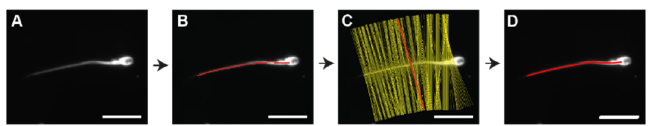
Figure 2. Reconstruction of the flagellum. ( A ) Each frame image is segmented and skeletonized to obtain ( B ) a rough track (red) of the flagellum; ( C ) along the flagellum, tangential vectors are determined to generate normal lines (yellow: normal lines; red: exemplary normal line). The intensity profile along each normal line is fitted to a Gaussian curve to obtain the center of the profile. The track points are then corrected by shifting them to the center, ( D ) resulting in a precise flagellar track (the precision of the track after correction is below the image resolution and thus, cannot be correctly displayed in the image). Bar: 20 µm.